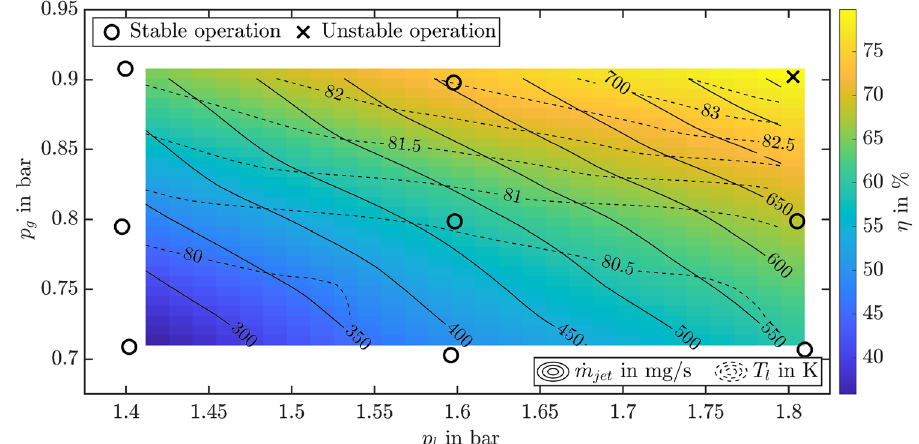
Figure 7. Operational diagram summarizing the conditions during device operation resulting from varying combinations of the pressures p l and p g . The pressure combinations used in the experiments are indicated in the diagram using symbols, where circles and crosses refer to stable and unstable operation, respectively. The data for ˙ m jet (solid lines) and T l (dashed line) as well as for η (color) is derived from cubic interpolation of the experimental